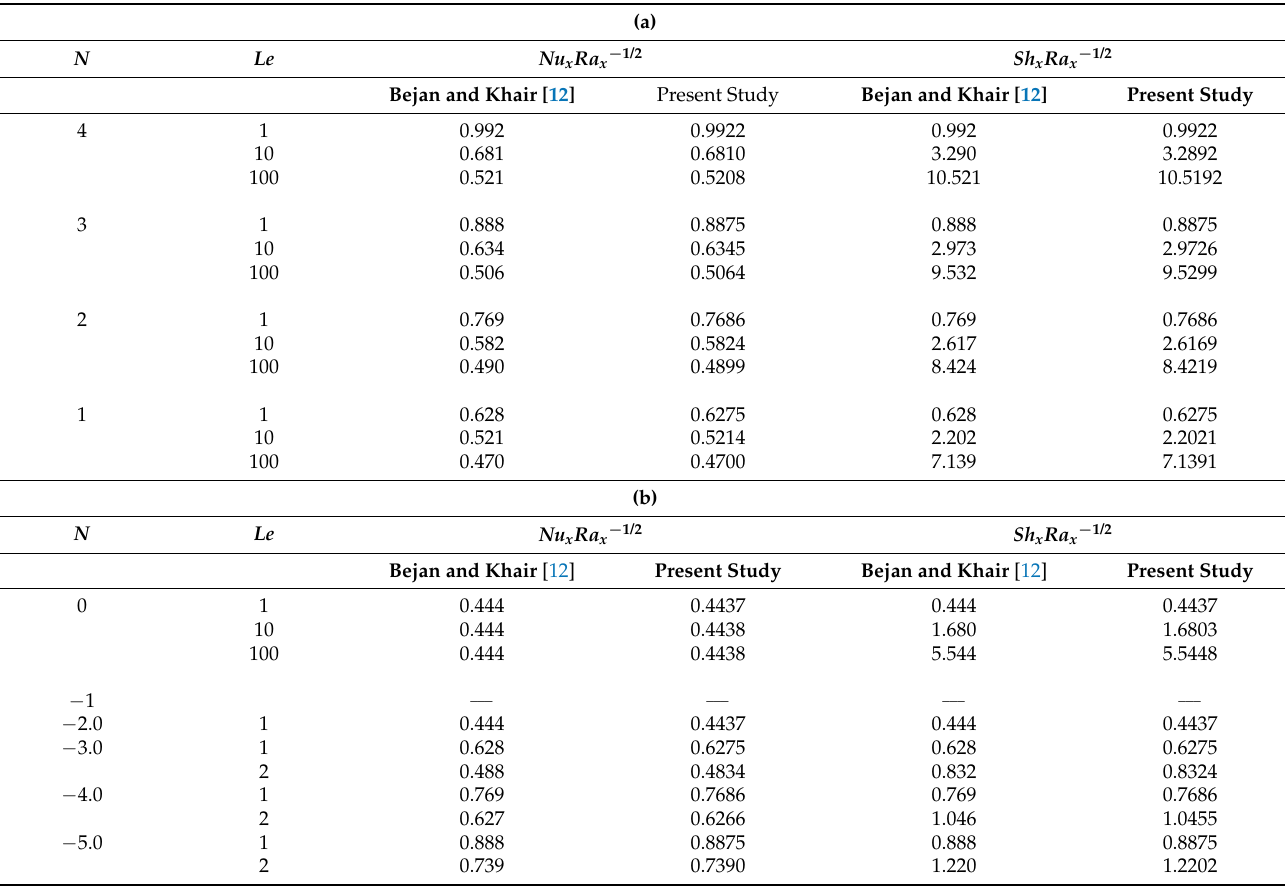
Table 1. Comparison of the values of the local Nusselt and Sherwood numbers with Bejan and Khair [12] for various parameters of N and Le